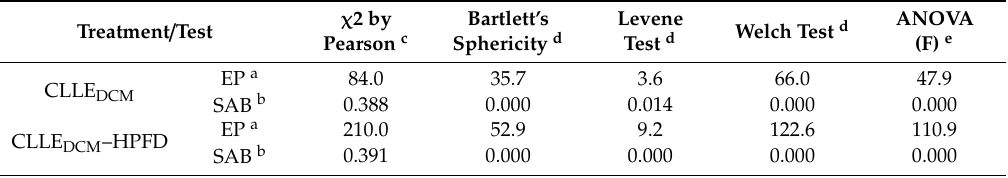
Table 7. Sample of results of the inferential and descriptive statistics of the application of CLLE DCM and CLLE DCM –HPFD in decontaminating the industrial wastewater (WW) of a sediment pool. χ 2 by Bartlett’s Levene Treatment / Test Pearson c Sphericity d Test